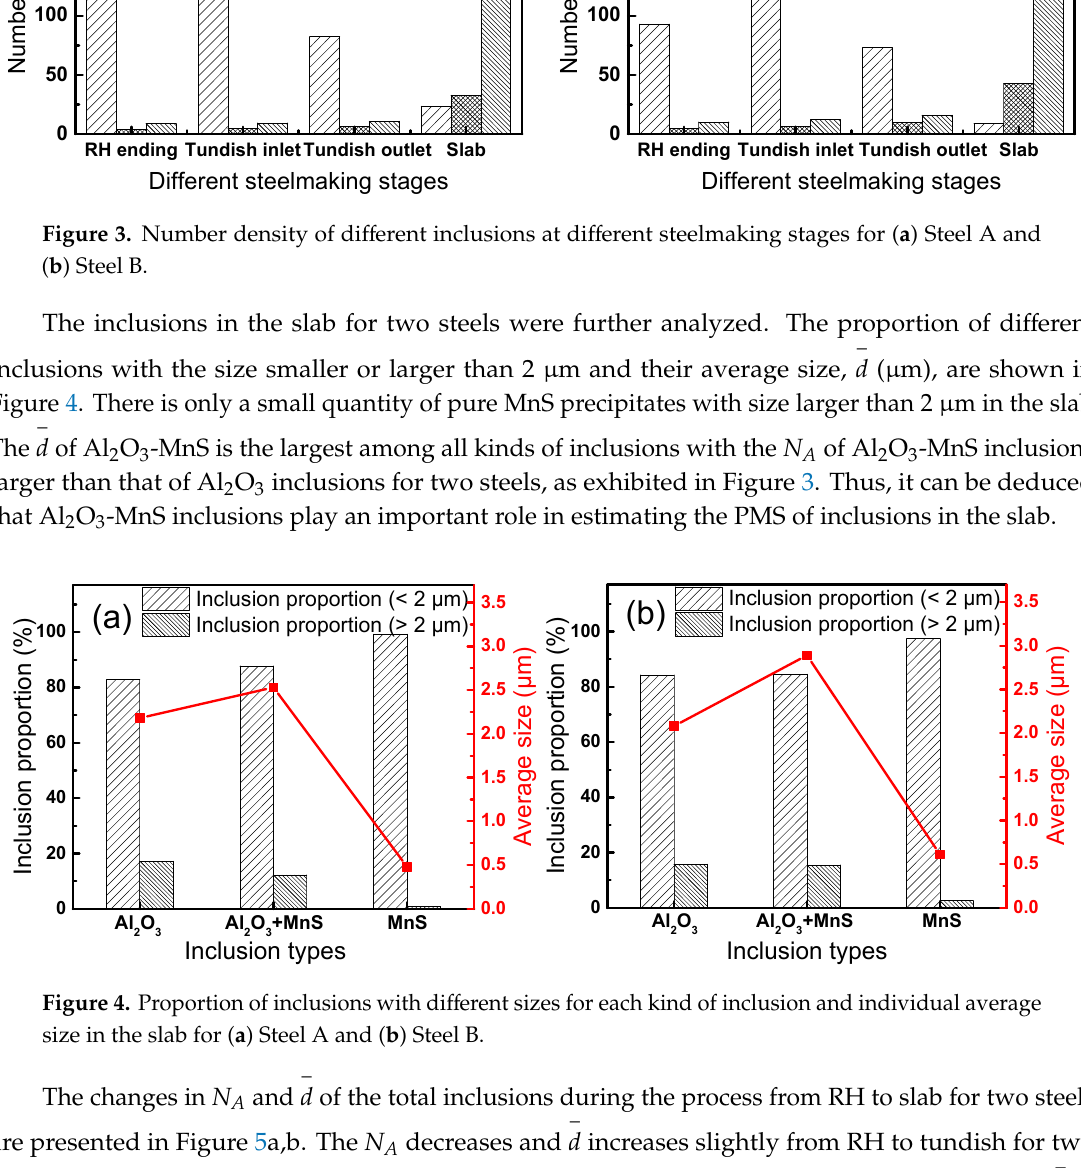
Figure 2. Changes in total oxygen content at different steelmaking stages.